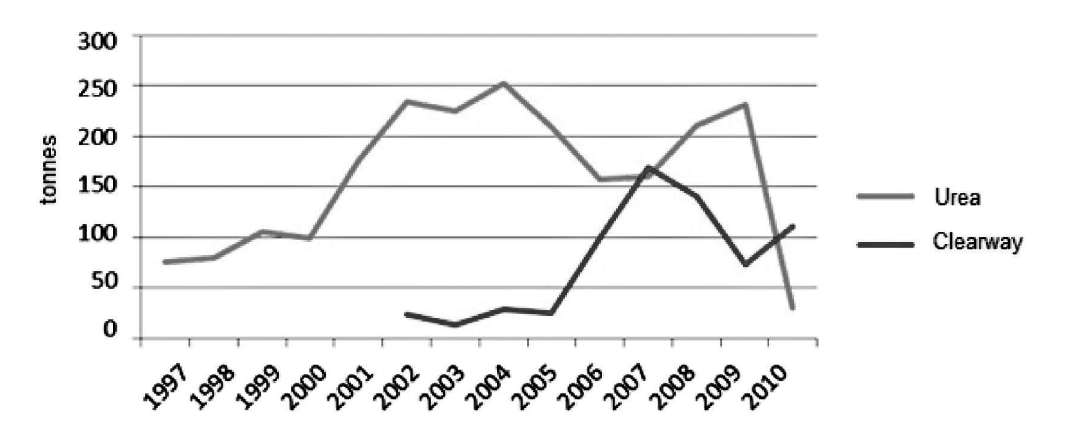
Fig. 7. Use of de-icing chemicals on runways in Tallinn Airport in 1997–2010 (Keskküla